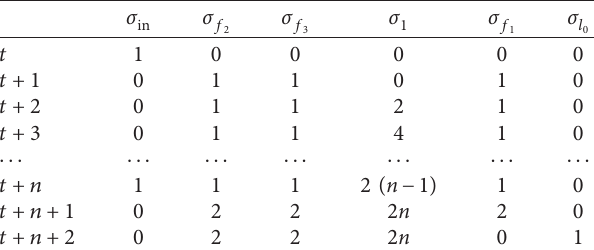
Table 3: The results of module